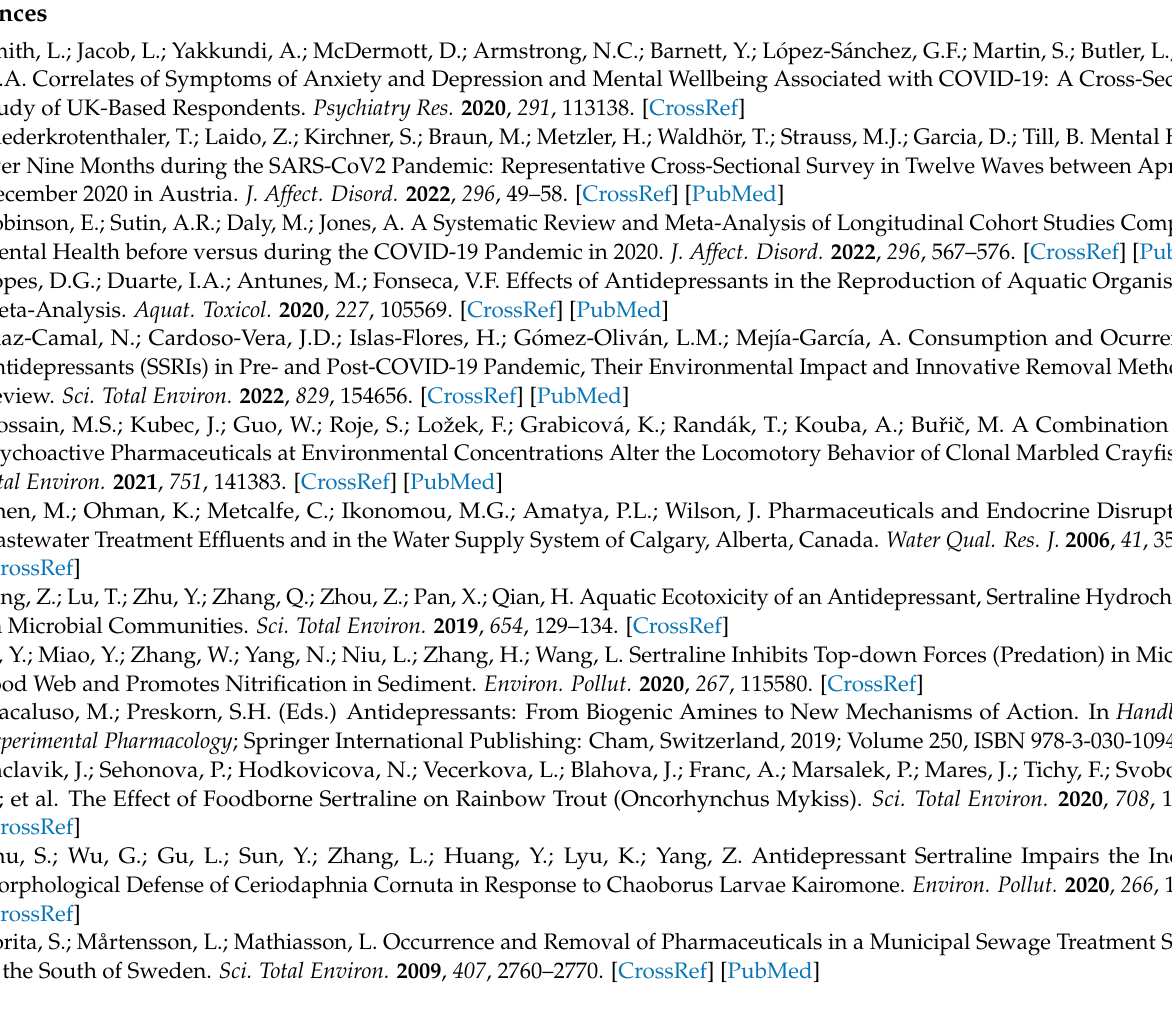
pathways on KEGG categories (level 1). Figure S2. Heat map of relative abundance of eukaryotes in different levels of treatment groups on the 6th, 12th and 18th days. (a) is at class level and (b) is at order level; C: sediment without paroxetine addition; L: 10 µ g/L paroxetine; M: 100 µ g/L paroxetine; H: 1000 µ g/L paroxetine. Table S1. Results of ANOVA for metabolism pathways in paroxetine treatment group. Table S2. Results of ANOVA for eukaryotic α -diversity at different concentrations and at different times. Table S3. Standardized total, direct and indirect effects of all the independent variables on dependent